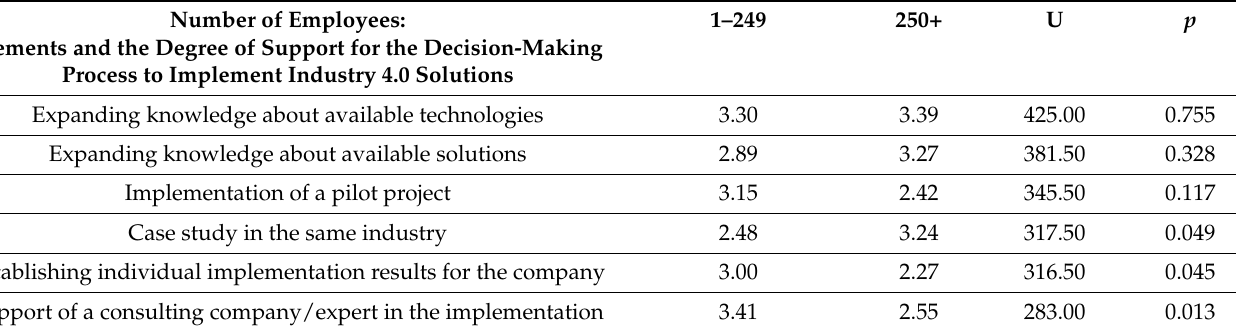
Table 16. Assessment of the degree of support for the decision-making process to implement Industry 4.0 solutions in companies employing up to 249 participants and in companies employing at least 250 participants.